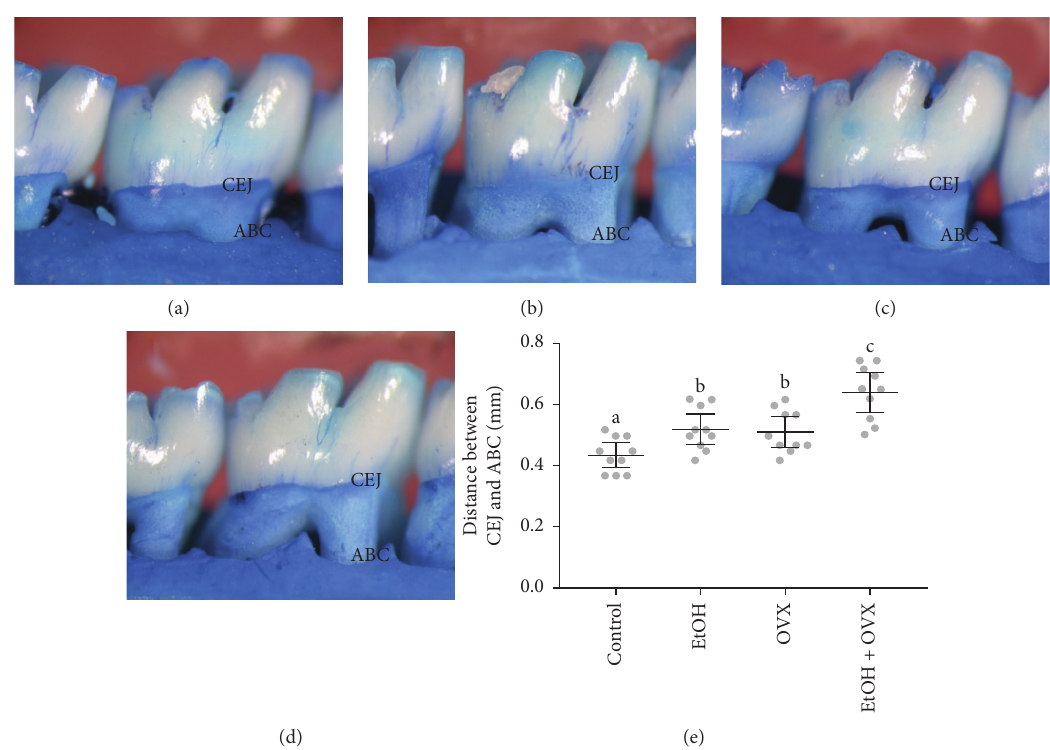
Figure 3: Effects of chronic administration of ethanol (during 55 days) and ovariectomy on the alveolar bone of female Wistar rats ( n � 10 per group). Representative photomicrographs hemimandibles of the (a) Control group, (b) Ethanol group (EtOH), (c) Ovariectomized group (OVX), and (d) Ovariectomized group and ethanol administration (EtOH +OVX). Results are expressed as mean and 95% CI of the mean of (e) distance between cement-enamel junction (CEJ) and the alveolar bone crest (ABC) in millimeters (mm). One-way ANOVA and Tukey’s post hoc test, p < 0 . 05. Similar overwritten letters mean no significant statistical